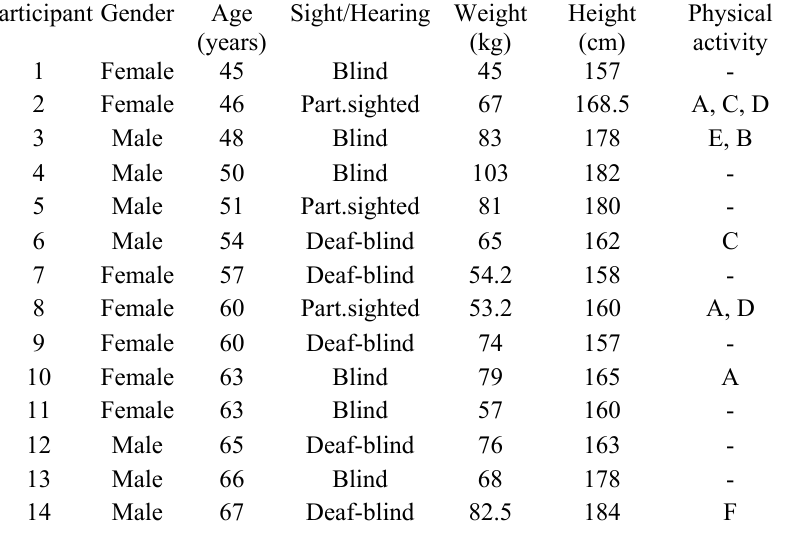
Table 2 Characteristics of Participants in Control